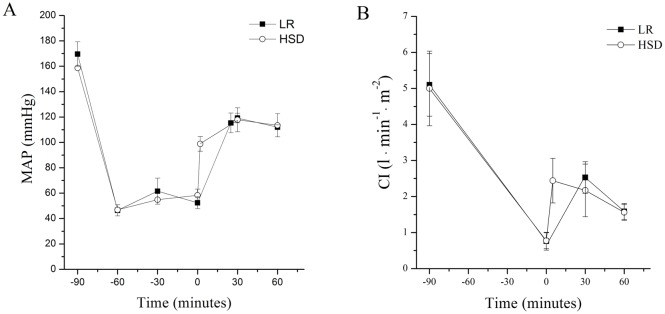
The changes of MAP and CI in the LR and HSD group during the pre-hospital period.(A) mean arterial pressure (MAP). (B) cardiac index (CI). A bolus of HSD (4ml/kg) was injected intravenously over a fixed interval of 2 min (HSD group). While, 40ml/kg Lactated ringers were intravenously infused at a constant rate of 20 ml/min (LR group). Therefore, the HSD infusion was completed more quickly and thus produced a faster increase in the MAP and CI than those with the LR infusion. *P<0.05 vs LR (black square); #P<0.05 vs HSD (open circle). n = 7 for all groups.